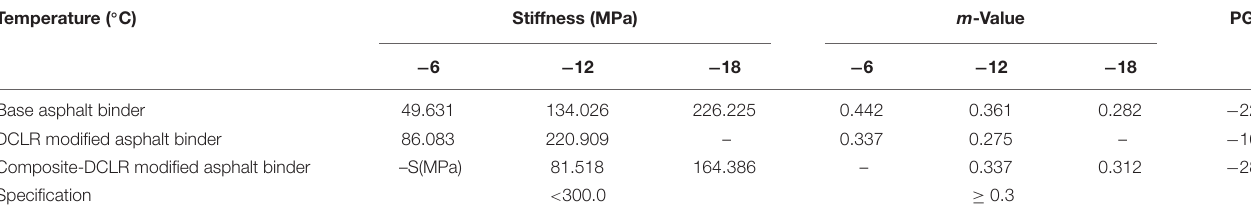
TABLE 2 | Stiffness and m -value of three asphalt